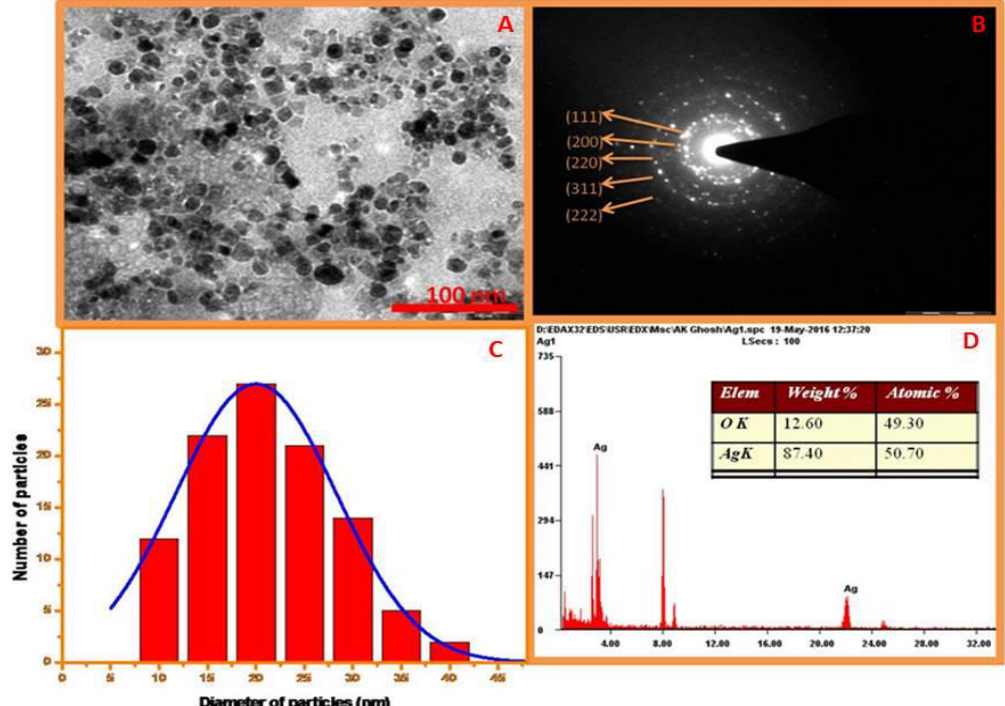
Fig. 3. The images represent the spherical shape (A), fcc crystal of silver (B), variable size (C) and elemental nature of silver nanoparticles (D)